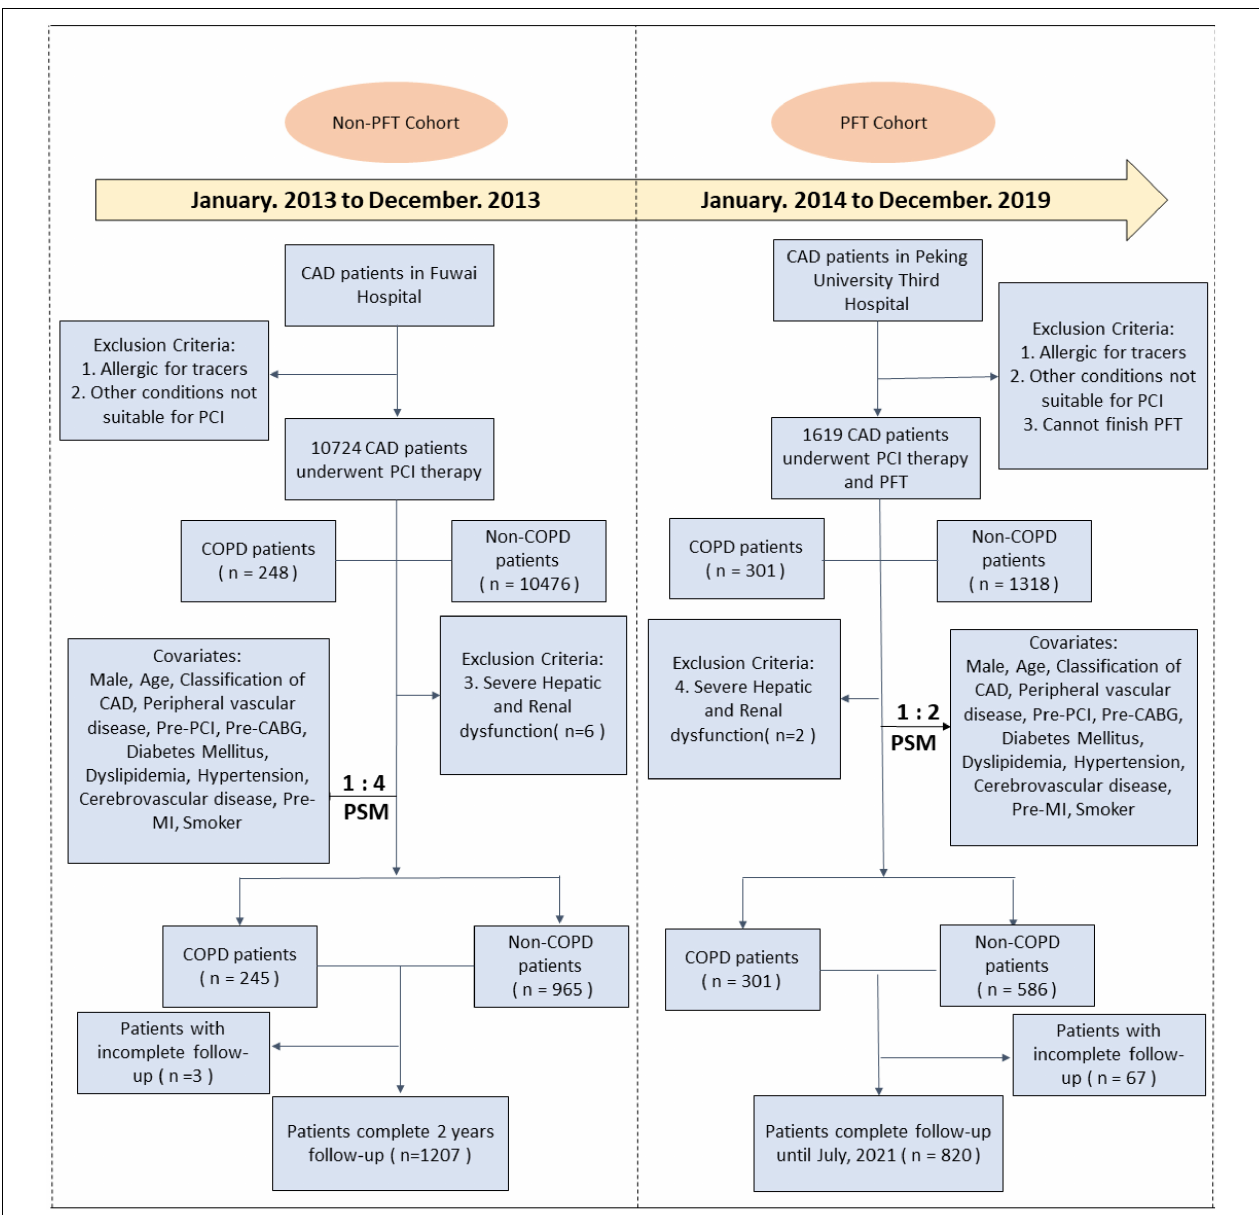
FIGURE 1 | Study flowchart of the non-PFT and PFT cohorts in two centers. PFT, pulmonary function testing; CAD, coronary artery disease; PCI, percutaneous coronary intervention; COPD, chronic occlusion pulmonary disease; CABG, coronary artery bypass graft; MI, myocardial